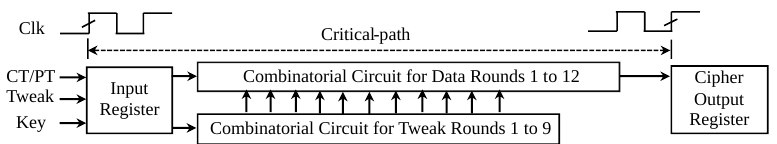
Figure 11: Unrolled micro-architecture for BipBip that estimates input to output